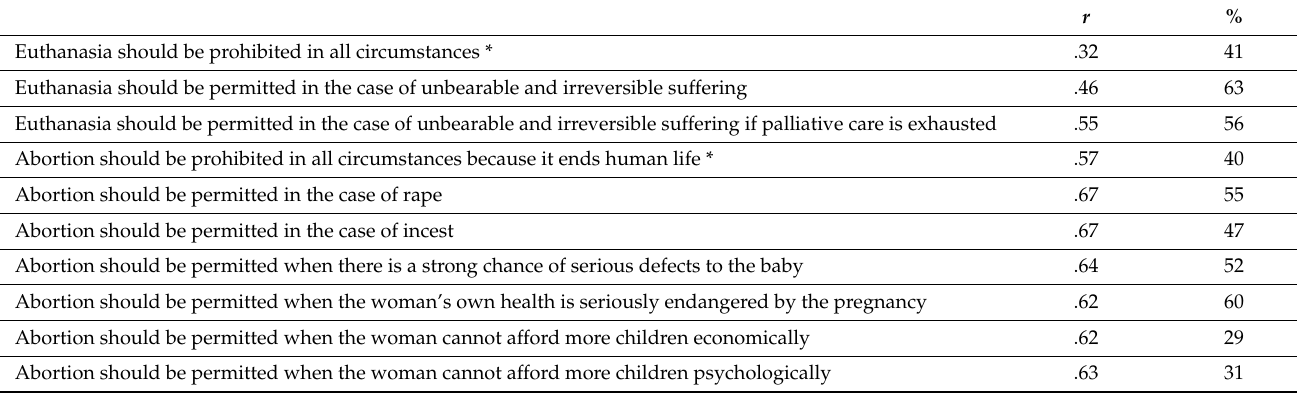
Table 2. Scale of Attitude toward Euthanasia and Abortion (SAEA): Scale properties.